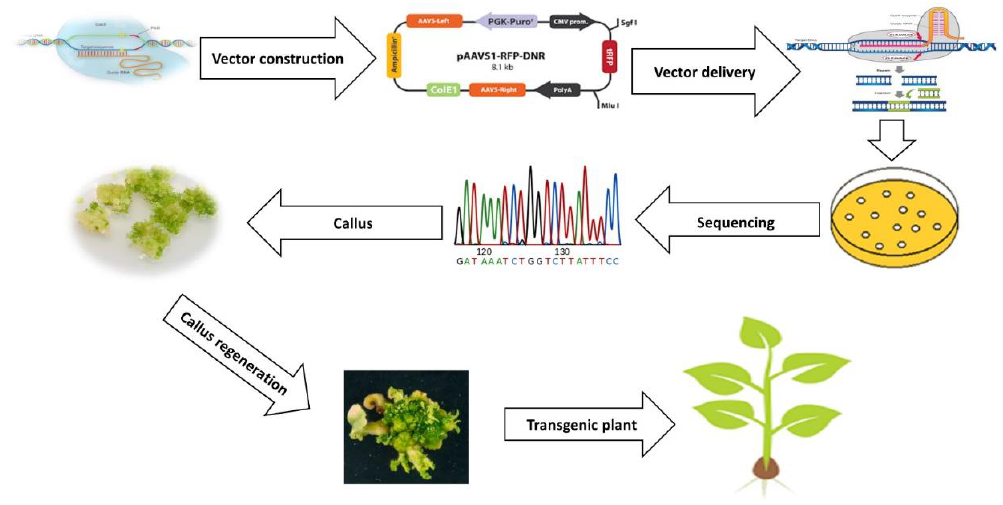
Figure 5. Overview of plant genome editing using the CRISPR (lustered Regularly Interspaced Short Palindromic Repeats)-Cas9 system .